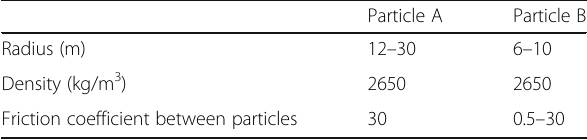
Table 1 Parameters of the particles used in the DEM simulation